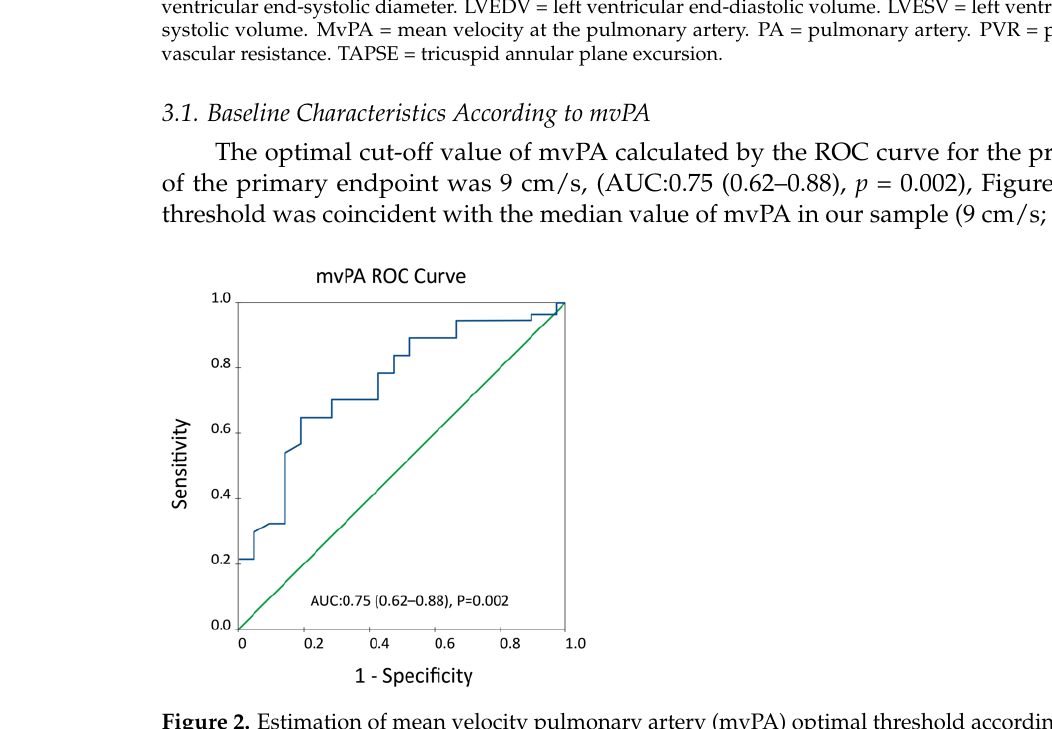
Figure 2. Estimation of mean velocity pulmonary artery (mvPA) optimal threshold according to ROC sensitivity/1-specificity curve to predict the primary combined endpoint.